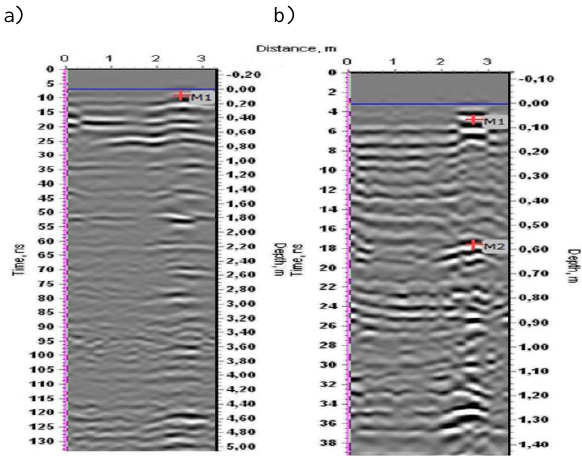
Figure 3 . The same GPR profile obtained with two antennas: 300 MHz (a) and 700 MHz (b).